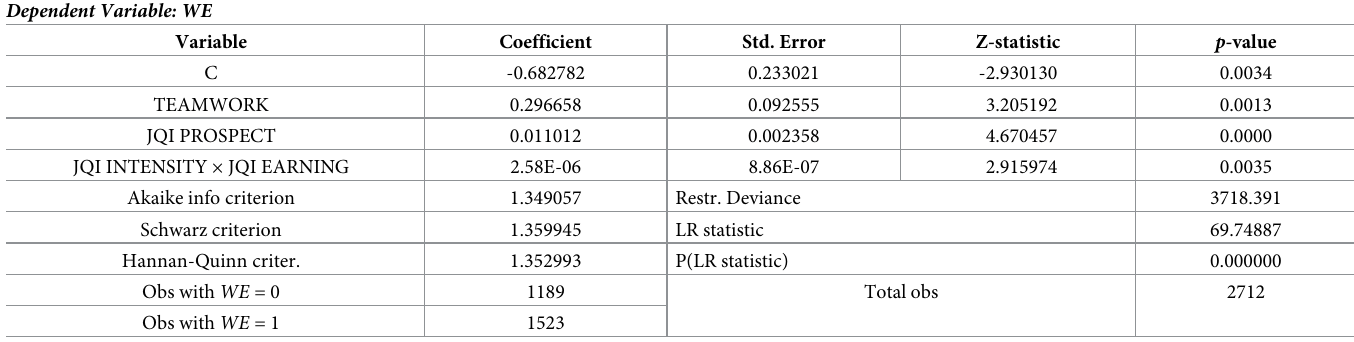
on WE. The likelihood ratio statistic, LR = 69.75, shows a good overall fit. In relation to the predictive capacity of the model, for a probability cut-point, c = 0.565 used to balance the pre- dictions in both groups, slightly more than 57% of correct predictions are obtained (Table 3). As indicated above, an alternative is to estimate a neural network to predict WE from the same variables used in the logistic regression, in order to corroborate the results presented with this model. A multilayer perceptron-type neural network is designed, configured by four input variables (JQI Factors) and TeamWork, a hidden layer with two neurons. The activation function used will be hyperbolic tangent (Fig 4). The classification Table 4 is obtained, and it shows that it slightly improves the predictive capacity of the logit model, but the difference is not considered sufficient to conclude that ANN is preferable. Classification results with the network (Table 4) are obtained in a similar